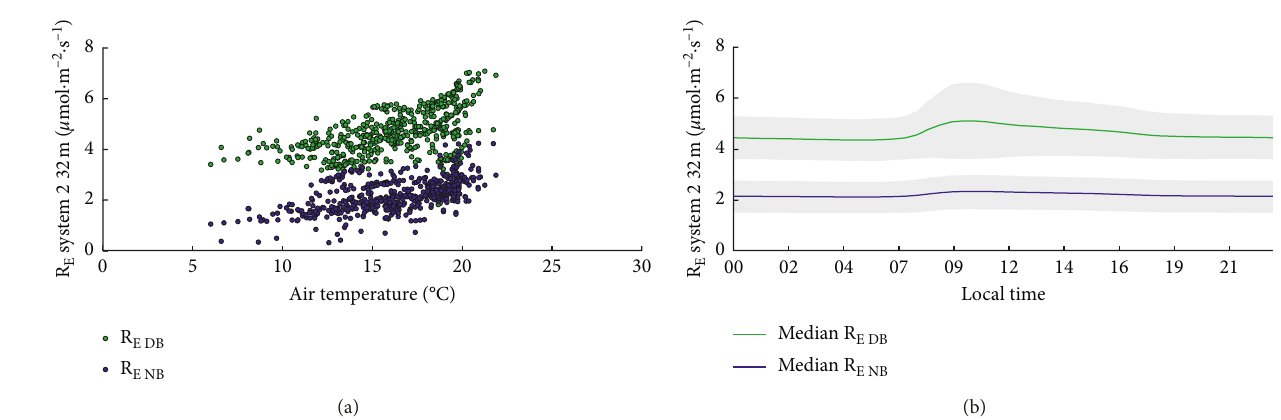
Figure 5: (a) Scatter plot of daily mean R E system 2 against daily mean air temperature; green symbols show data for the daytime partitioning model R E_DB ; blue symbols show data for the nighttime partitioning model R E_NB . (b) Median daily course of R E_DB and R E_NB for system 2; grey areas indicate one standard